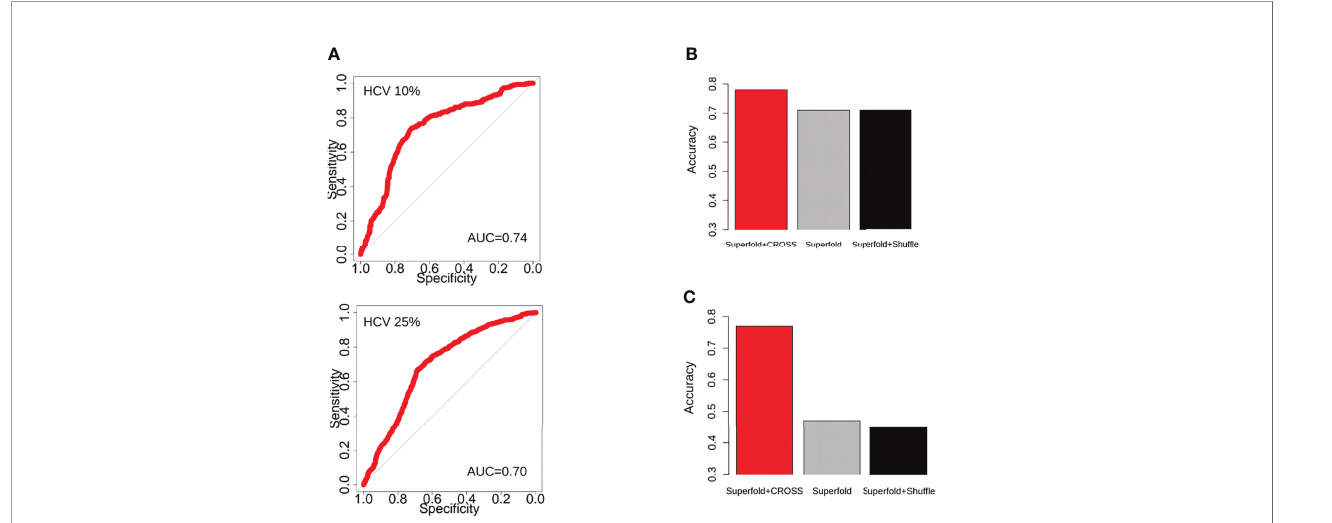
FIGURE 2 | (A) ROC curves and AUCs of the CROSS algorithm to predict the top and bottom (10 – 25%) nucleotides ranked for their SHAPE reactivity for HCV. The 25% corresponds to half of the dataset. (B) Barplot showing the performance (Accuracy) of Superfold while using the best SHAPE-like normalisation of CROSS (red), an empty Shape-MaP fi le (gray), and the shuf fl ed CROSS pro fi le (black), compared with the structure (same interactions for paired nucleotides) obtained with Superfold using SHAPE-MaP for HCV ( fi rst 1,500 nt) as input. (C) Barplot showing the performance (Accuracy) of Superfold while using the best SHAPE-like normalization of CROSS (red), an empty Shape-MaP fi le (gray), and the shuf fl ed CROSS pro fi le (black), compared with the structure (same interactions for paired nucleotides) obtained with Superfold using SHAPE-MaP for DENV-1 (last 1,000 nt) as